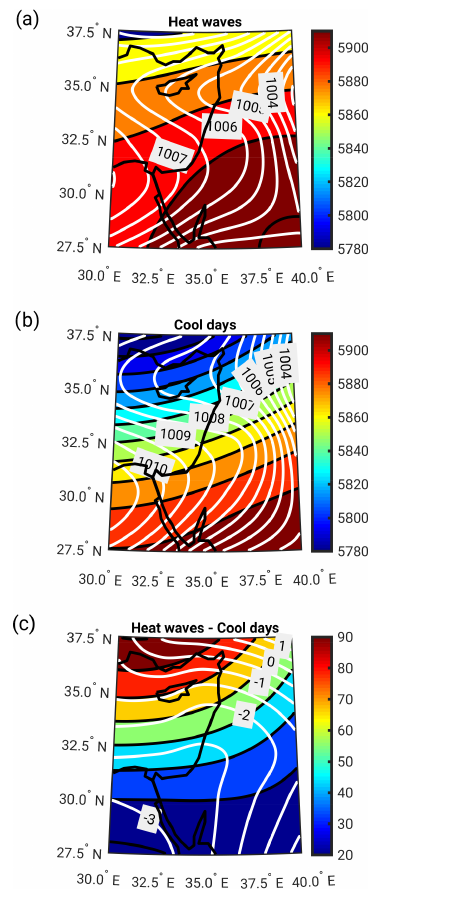
Figure 1. Mean sea level pressure (SLP, inhPa, white contours) and 500hPa geopotential height ( Z 500, in m, colored shading) for the 10% of days with the highest (heat waves) and lowest (cool days) climatic stress index (CSI) values: (a) heat wave days mean composite; (b) cool days mean composite; (c) heat waves minus cool